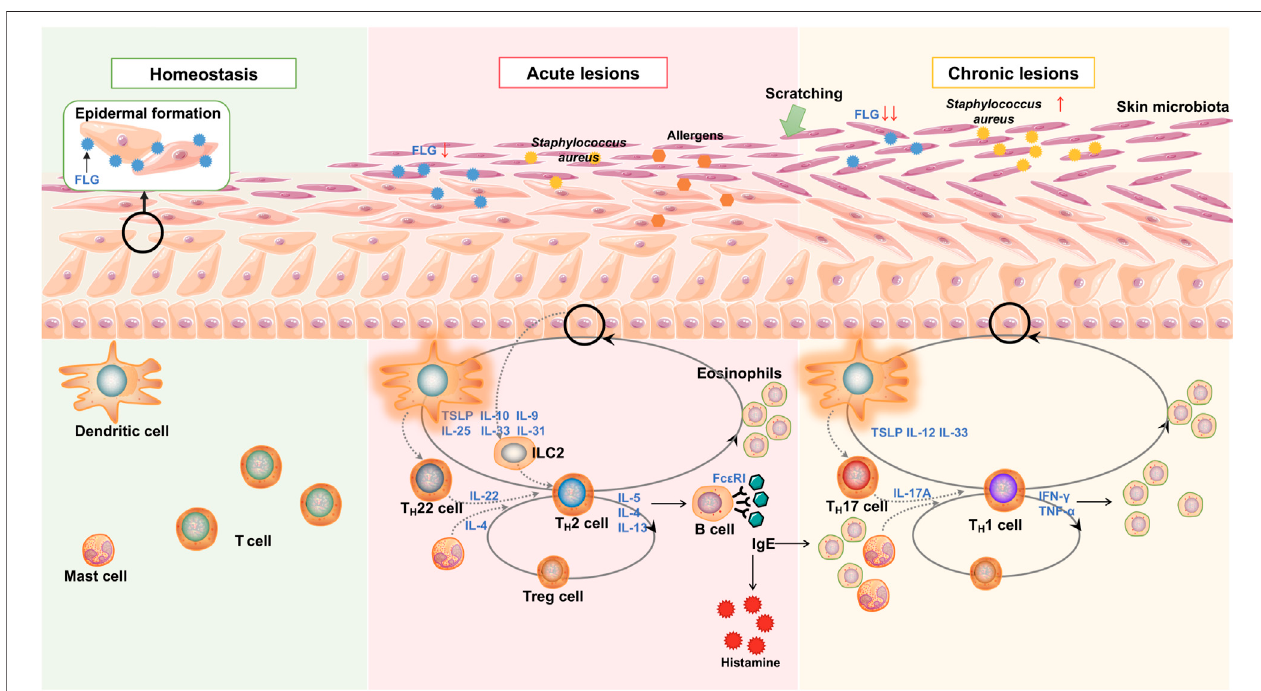
FIGURE 1 | Main pathogenesis and mechanisms of AD. Epidermal barrier disruption mainly caused by mechanical scratch and aberrant in fl ammatory reactions. Reduced FLG contributes to in fl ammatory changes, while the releasing proin fl ammatory cytokines and chemokines result in further FLG de fi ciency. It is a positive feedback loop. LC and DC recognize the allergens and microbial components and stimulate adaptive immune responses — predominantly T H 2/T H 22 bias in the acute phase andT H 1/T H 17biasinthechronic phase.Therelease ofalarmins (includingIL-10,IL-31,andTSLP) fromepithelialcellspromotesILC2inductionasaninnate immune response and aggravates T H 2 immune response. T H 2 cytokines IL-4, IL-5, and IL-13 recruit eosinophils and increase B cell IgE production during the acute phase. IL-22, produced by T H 22, promotes T H 2-type in fl ammation. In the chronic stage, T H 1 and cytokines predominate in skin lesions, leading to further in fl ammation and epidermal hyperplasia. In fl ammatory cytokines simultaneously impair the skin barrier by inhibiting barrier proteins and disrupting skin microbiota, thereby increasing the risk of S. aureus